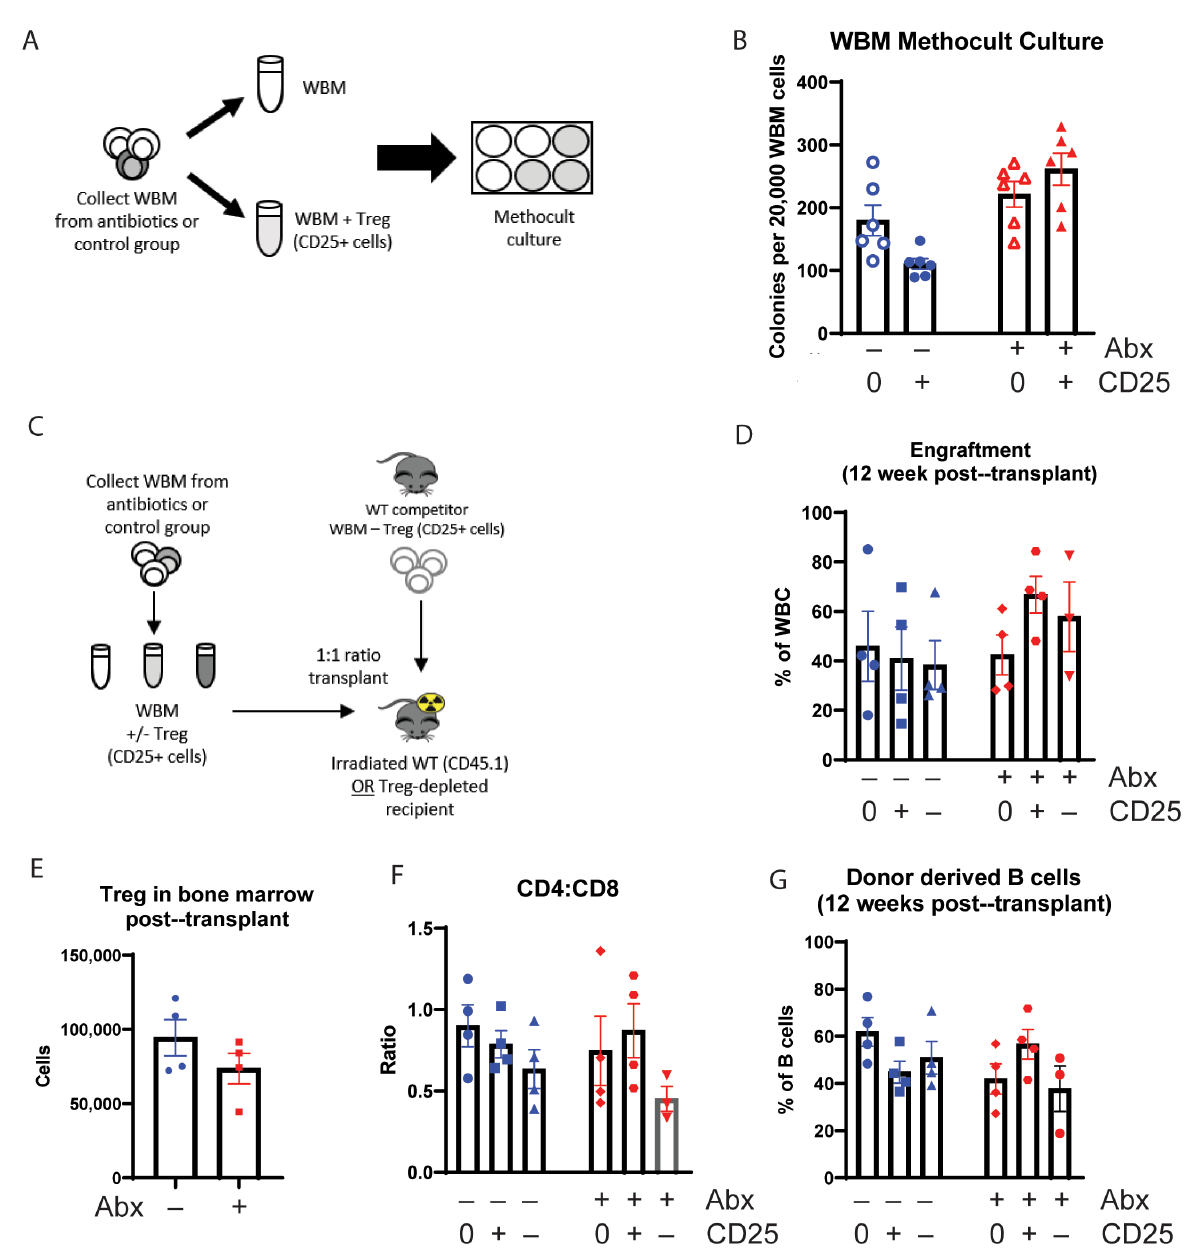
Figure 3. Addition of Treg (CD25+ cells) to antibiotic-treated mice whole bone marrow (WBM) improve cell count in vitro and engraftment in vivo. ( A ) Methocult culture experiment design ( B ) Colonies from WBM cells were counted in six replicates on day 5 for each group. Results are compiled from 1 independent experiment, n = 2–3. ( C ) Bone marrow transplant (BMT) experiment design using Treg-depleted recipient mice ( D ) Engraftment at 12 weeks after transplant analyzed from WBC from donor cells using flow cytometry. ( E ) Treg population from WBM at 16 weeks after transplant using flow cytometry. ( F ) CD4:CD8 ratio from WBM at 16 weeks after transplant. ( G ) B cell contribution from donor-derived WBC at 12 weeks after transplant. N = 3–5. Graph show mean + SEM. No statistical differences by